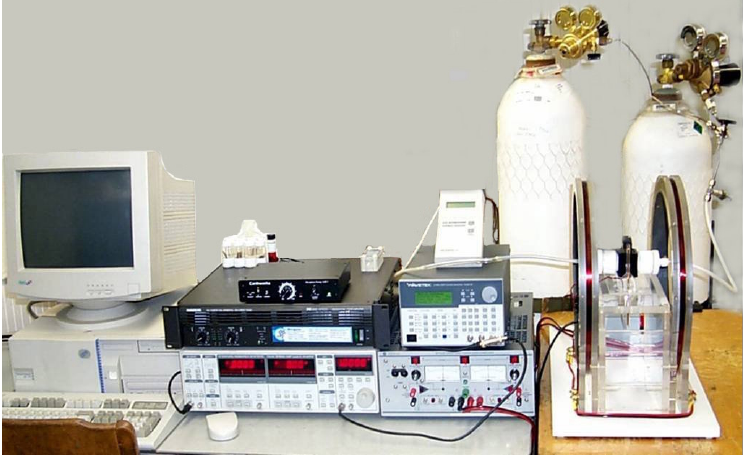
Figure 3. The magnetoelastic sensor system. A signal generator sends a pulse-like excitation signal, appropriately amplified, to the interrogation coils. The response of the sensor, located in the white tube placed between the two coils, is monitored with a pickup coil the output of which is passed to a lock-in amplifier. A computer controls the instrumentation and plots measured parameters as a function of time.